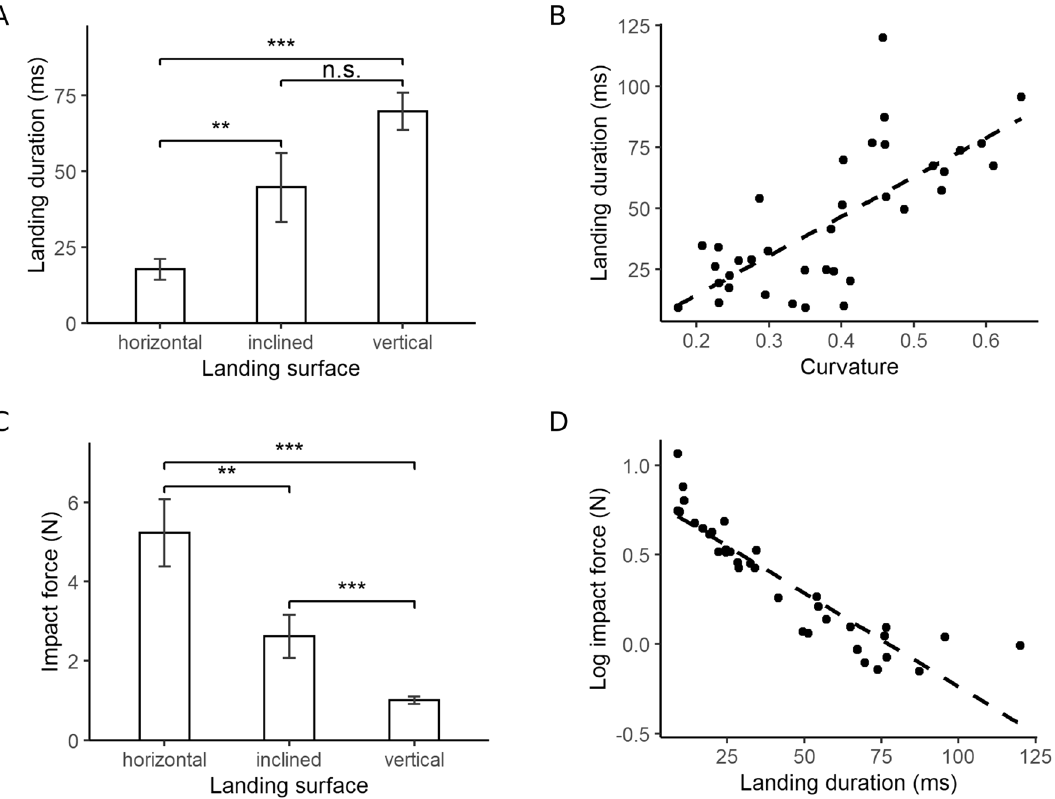
Figure 9. Influence of body curvature and landing duration on impact force. ( A ) Landing duration for each platform incline. ( B ) Correlation between maximal body curvature and landing duration (p = 5.5 × 10 –7 , r 2 = 0.51). ( C ) Impact force acting on the gecko’s body during landing on the different surfaces. ( D ) Correlation between landing duration and log-transformed impact force (p = 4.3 × 10 –14 , r 2 = 0.81). Bar plots show mean values and standard errors. n.s.: no significance; **: 0.001 < p < 0.01; ***: p <